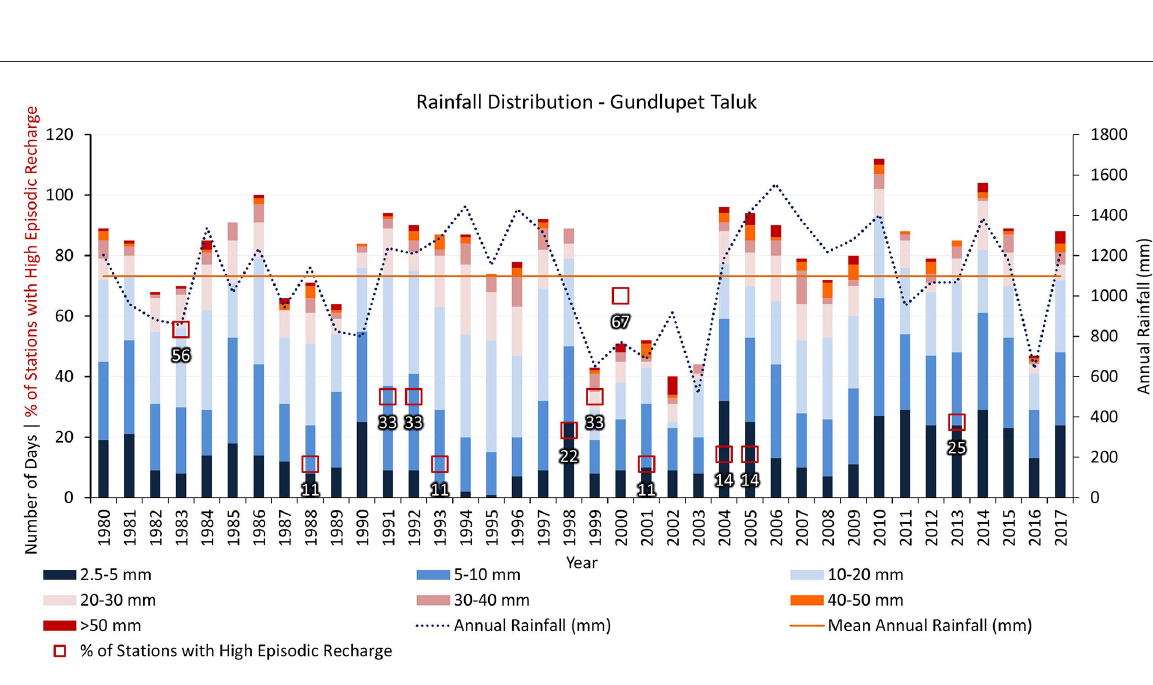
FIGURE6 Rainfall distribution and high-episodic recharge events for Gundlupet